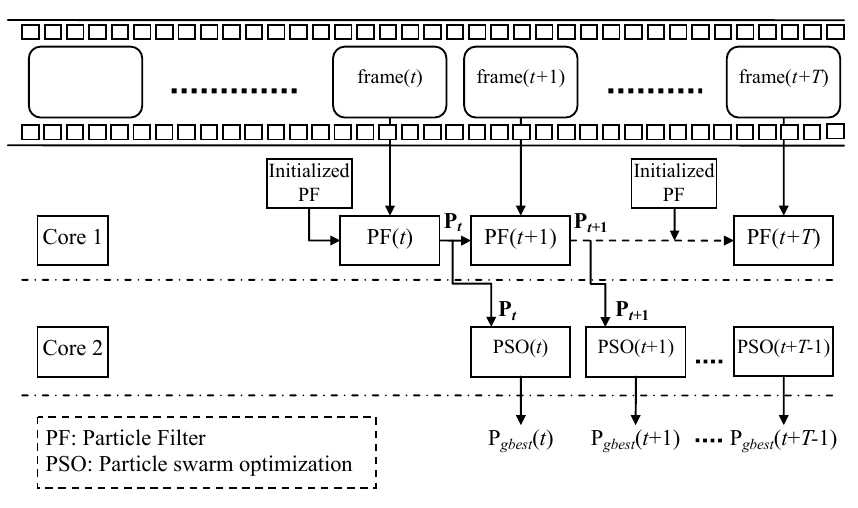
Figure 1. The block diagram for PSO-PF